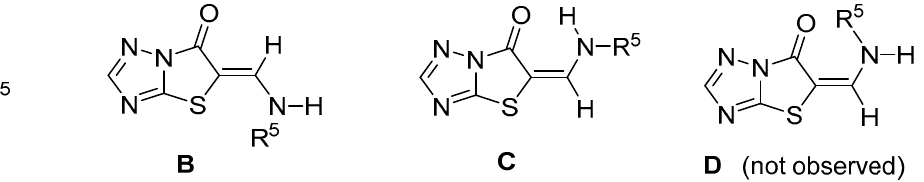
Scheme 3. Possible stereoisomeric/rotameric forms of 5a – h .